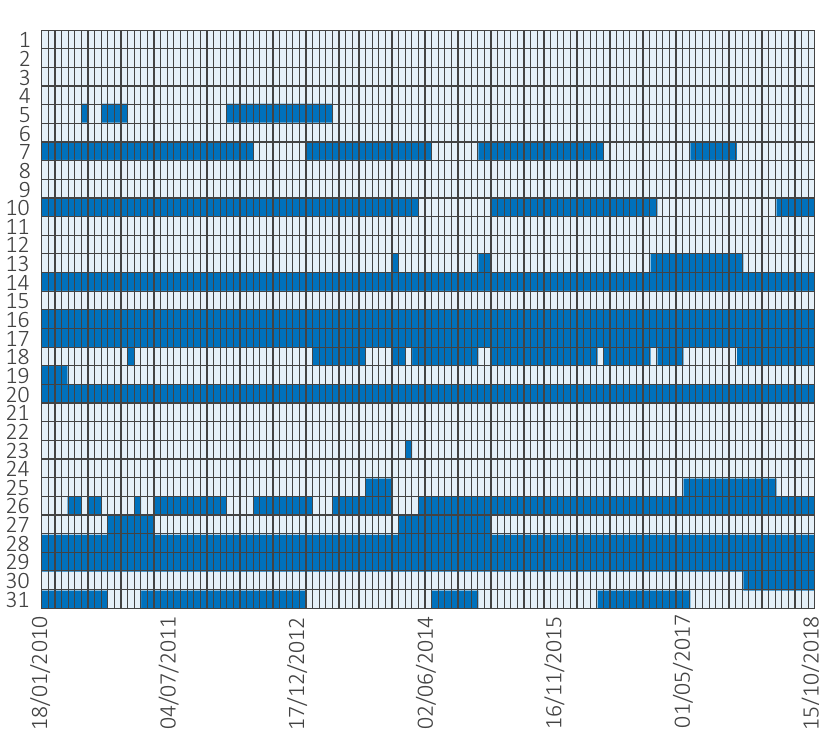
Figure 1. Ten preselected assets for each rebalancing date using Z-score preselection